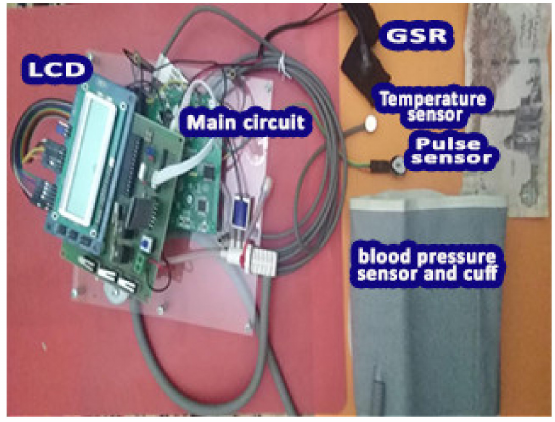
Figure 3. EGYXOS